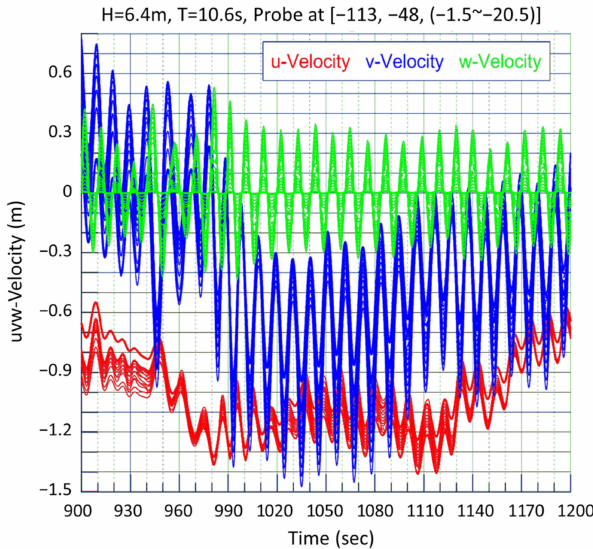
Figure 34. Time series of u, v, w